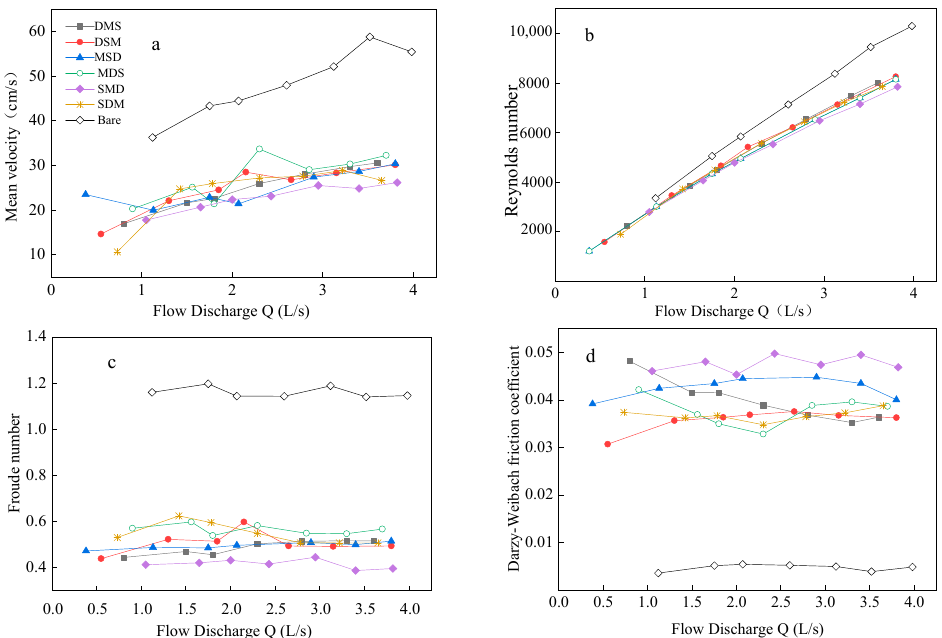
Figure 4. Variations in the ( a ) mean velocity, ( b ) Reynolds number, ( c ) Froude number and ( d ) Darcy–Weisbach coefficient f with different flow discharges. Table 2. Relationship between the mean velocity and flow discharge. Configurations Regression Equation